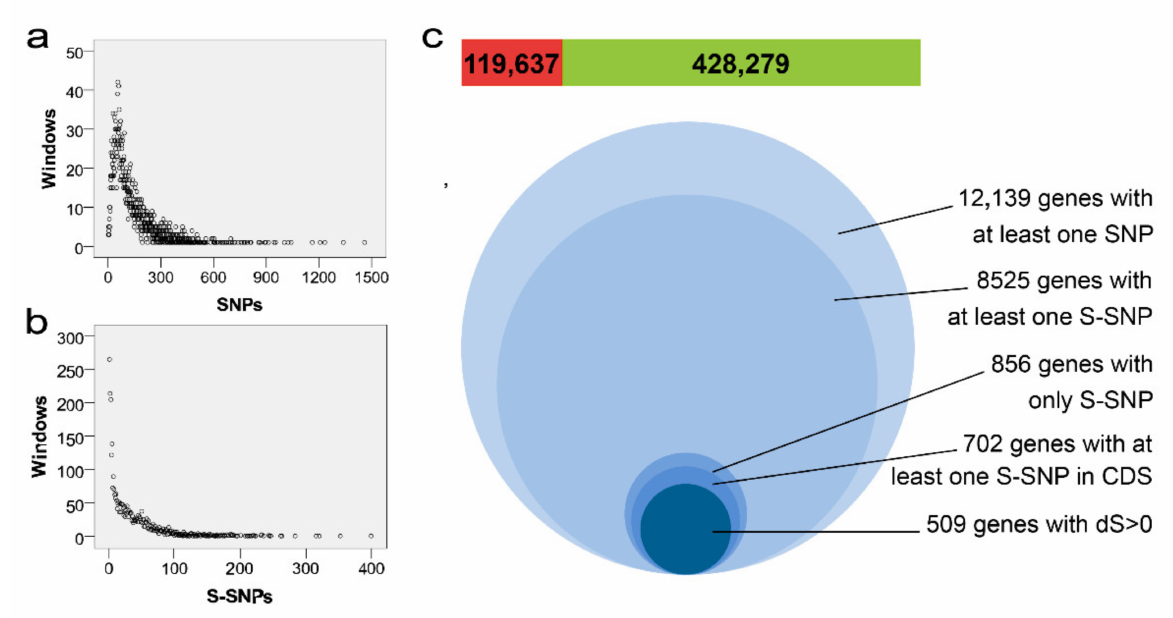
Figure 2. Windows and Genes affected by SNPs. Distribution of windows on chromosome against the corresponding SNPs ( a ) and S-SNPs ( b ). ( c ) The number of sites in the two classes and the genes affected by different mutations. The numbers in the green and red bars indicated the number of identified sites for S-SNPs and SNPs, respectively. Circles with different sizes represented the number of genes with different mutations due to